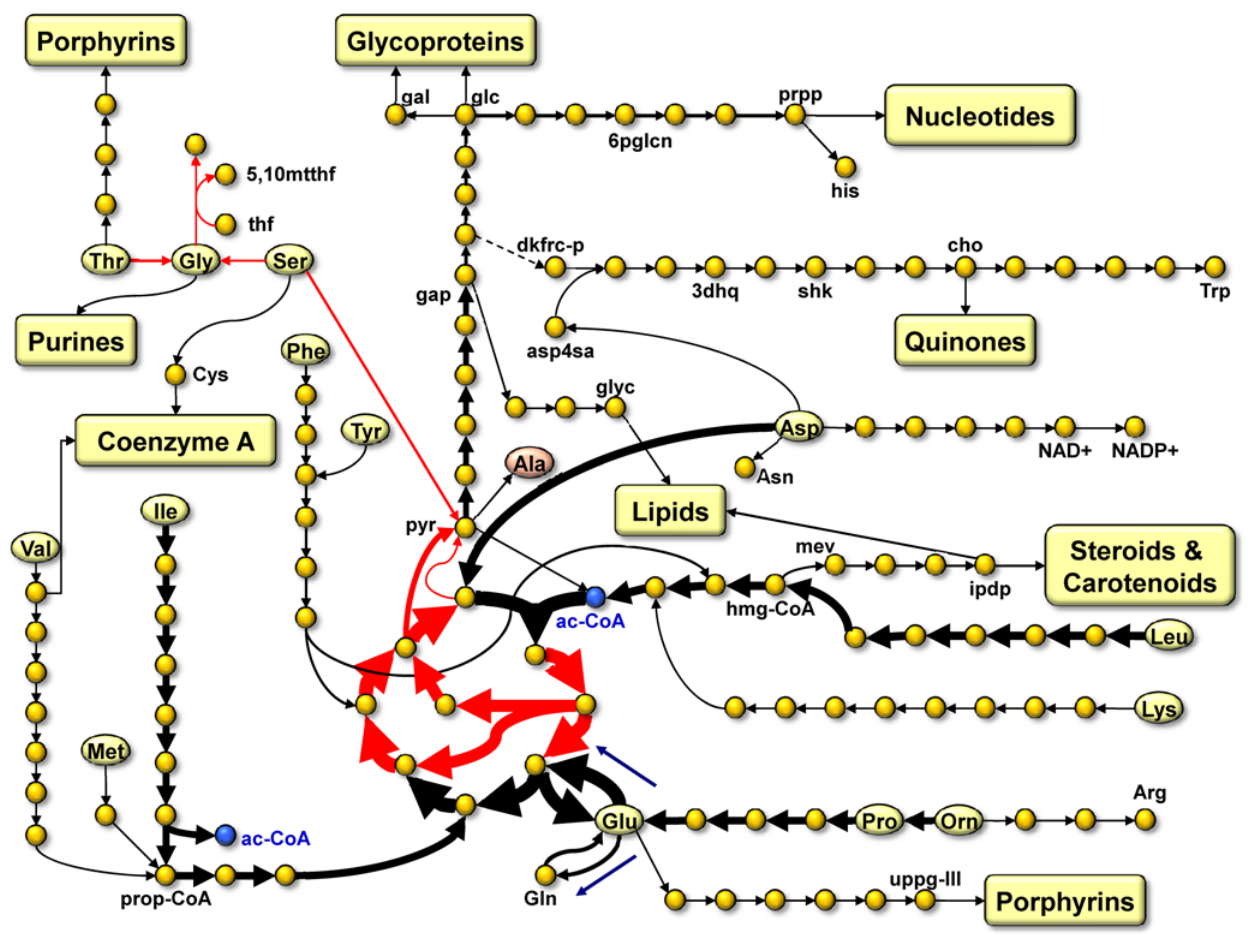
Figure 5. Predicted fluxome during exponential phase ( t = 30 ) that maximizes energy production. Yellow ellipses represent compounds that are taken up from the medium, while light-red ellipses represent those that are accumulated in the medium. Larger fluxes are drawn with thicker arrows. Black and red arrows correspond to qualitatively invariable and qualitatively variable (see main text) fluxes, respectively. Side reactants, for the most part, are not depicted in the figure. Yellow rounded boxes represent biochemical pathways. Metabolite abbreviations: 3dhq - 3-dehydroquinate, 5,10mtthf - 5,10-methylenetetrahydrofolate, 6pglcn - 6-phosphogluconate, ac-CoA - acetyl-CoA, Ala - alanine, Asn - asparagine, Asp - aspartate, asp4sa - aspartate 4-semialdehyde, Arg - arginine, Cys - cysteine, dkfrcp - 6-deoxy-5-ketofructose 1-phosphate, gal - galactose, gap - glyceraldehyde 3-phosphate, cho - chorismate, glc - glucose, Gly - glycine, glyc - glycerol, Glu - glutamate, Gln - glutamine, His - histidine, hmg-CoA - 3-hydroxy-3- methyl-glutaryl-CoA, ipdp - isopenteny diphosphate, Ile - isolecuine, Leu - leucine, Lys - lysine, Met - methionine, mev - mevalonate, Orn - ornithine, Phe - phenylalanine, Pro - proline, prop-CoA - propanoyl-CoA, prpp - 5-phosphoribosyl diphosphate, pyr - pyruvate, Ser - serine, shk - shikimate, thf - tetrahydrofolate, Thr - threonine, Trp - tryptophan, Tyr - tyrosine, uppg-III - uroporphyrinogen III, Val -